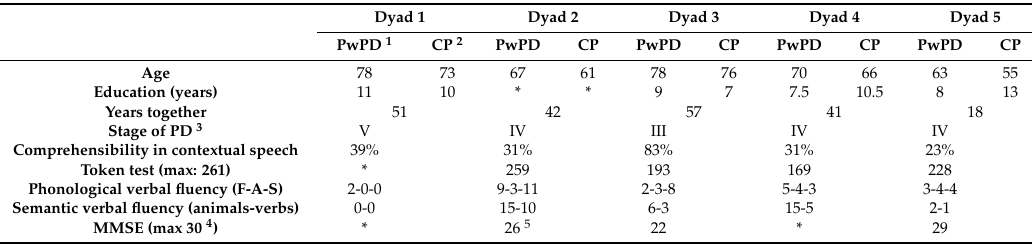
Table 1. Participant information and results on language and cognitive screening